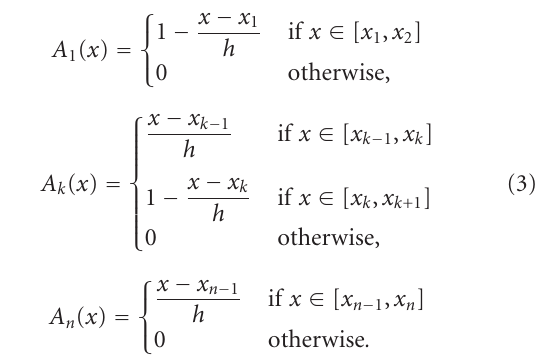
Figure 1. For each context w i , i = 1, ... , r , of the dataset in Table 1, an initial uniform fuzzy partition of n i triangular fuzzy sets (3) is